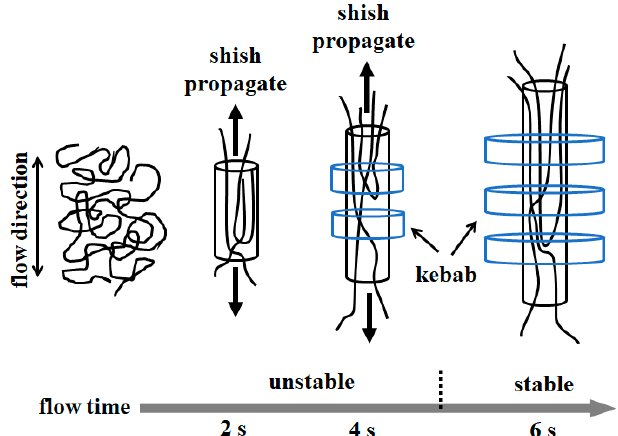
Figure 7. Schematic illustration of the development of shish-kebab structure affected by different flow time.